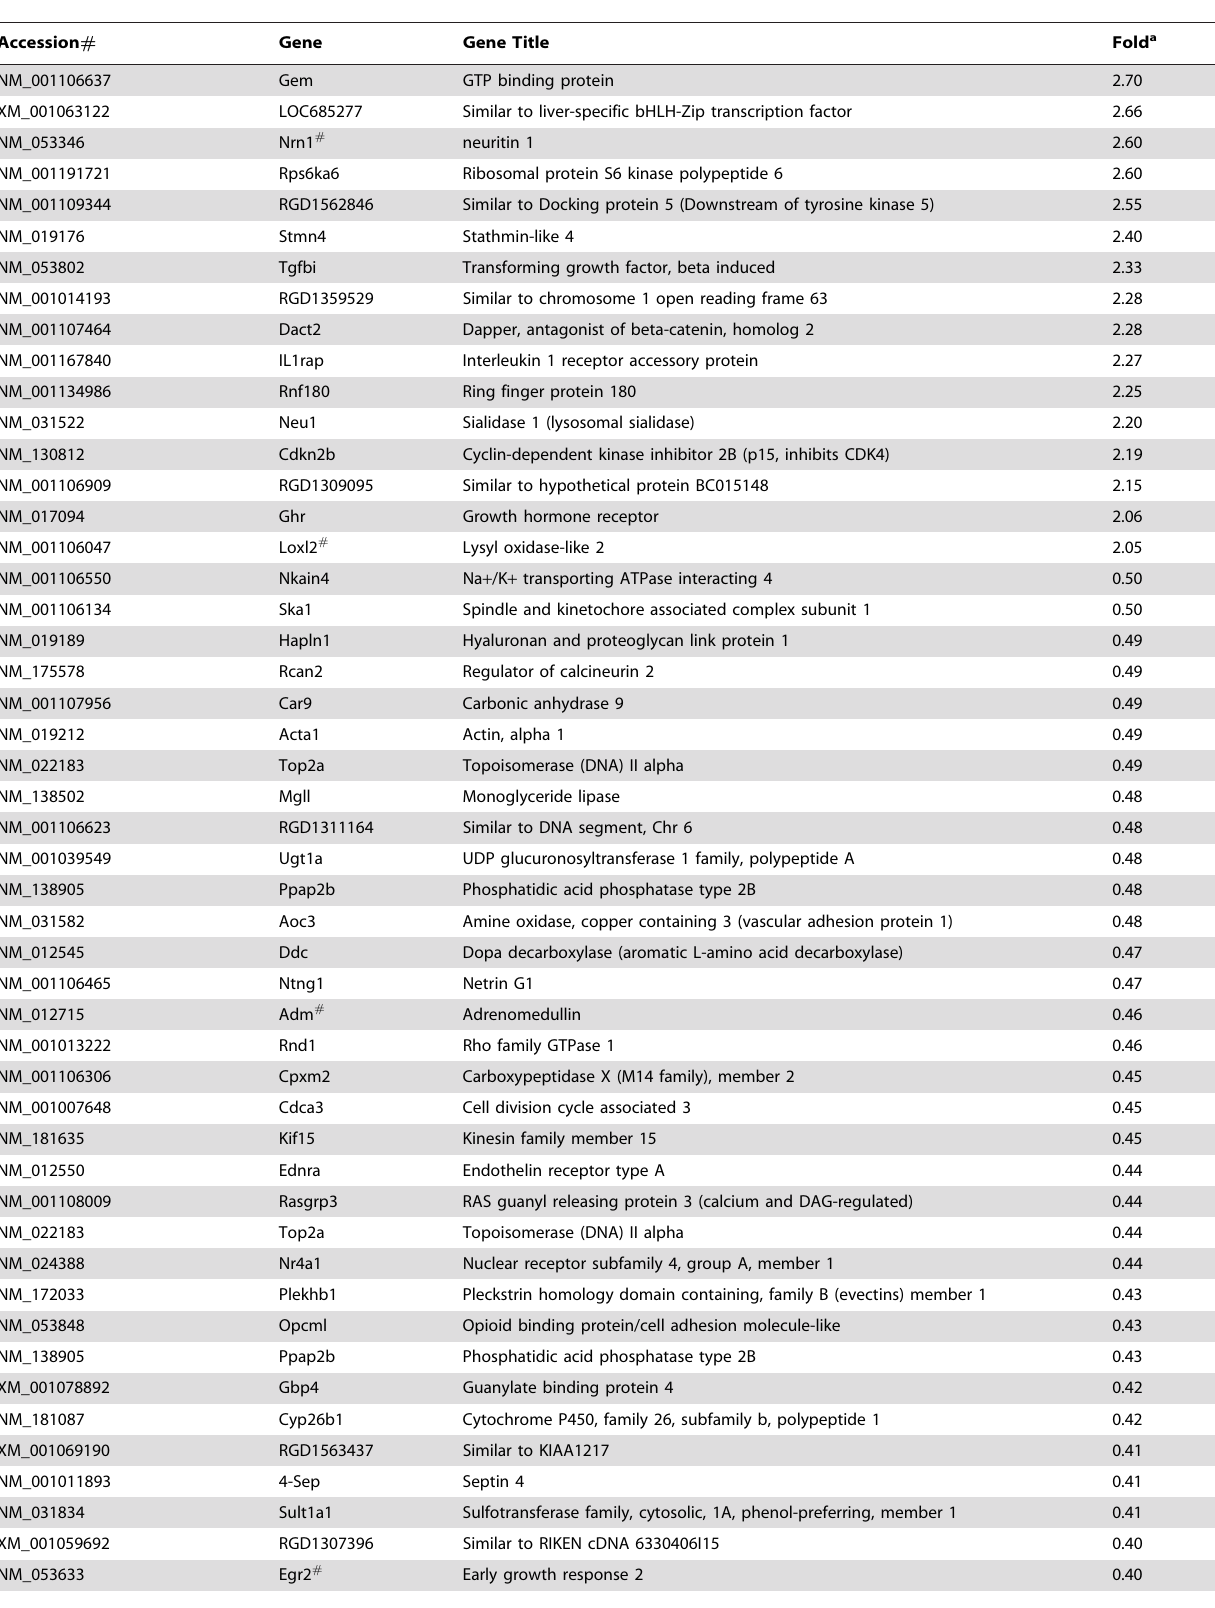
Table 2. Up- and downregulated Genes (p , 0.05, more than twofold change) in Mu¨ller cells after stretching for 24